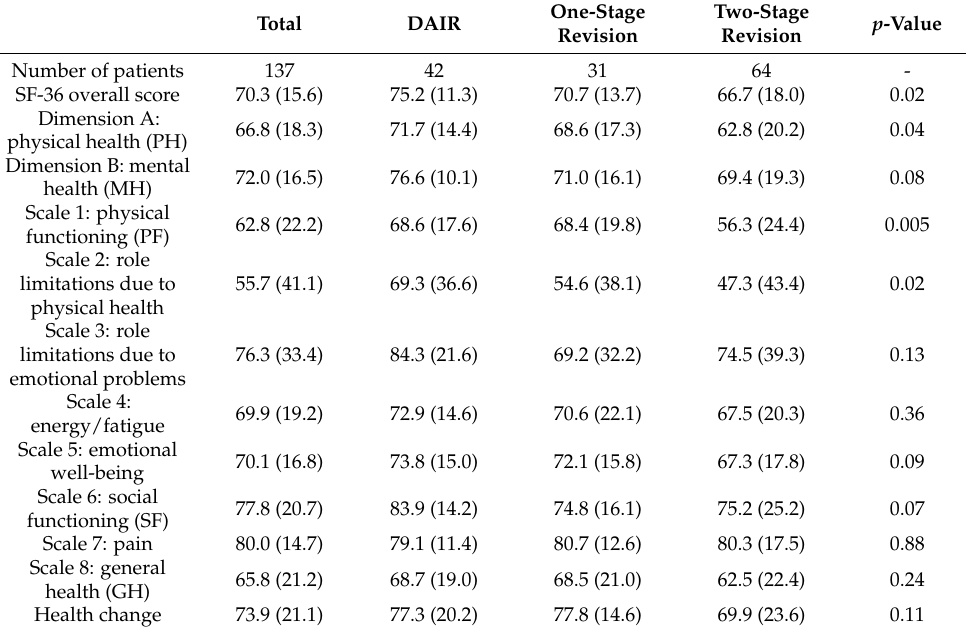
Table 2. Overall and subscale scores of SF-36 among the three